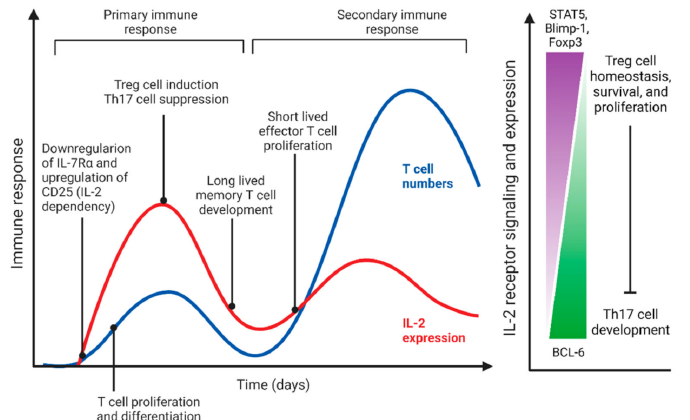
Figure 1. IL-2 as a density-dependent QS-like regulator of T cells. IL-2 and its receptor (CD25) are upregulated in T cells upon activation, leading to density-dependent changes and dose-dependent synchronization of the immune response. Low-dose IL-2 signaling leads to proliferation of early- activated T cells, their differentiation into effector cells, and development of memory T cells. High- dose IL-2 induces Treg cell activation and Th17 cell suppression through control of transcription factors and